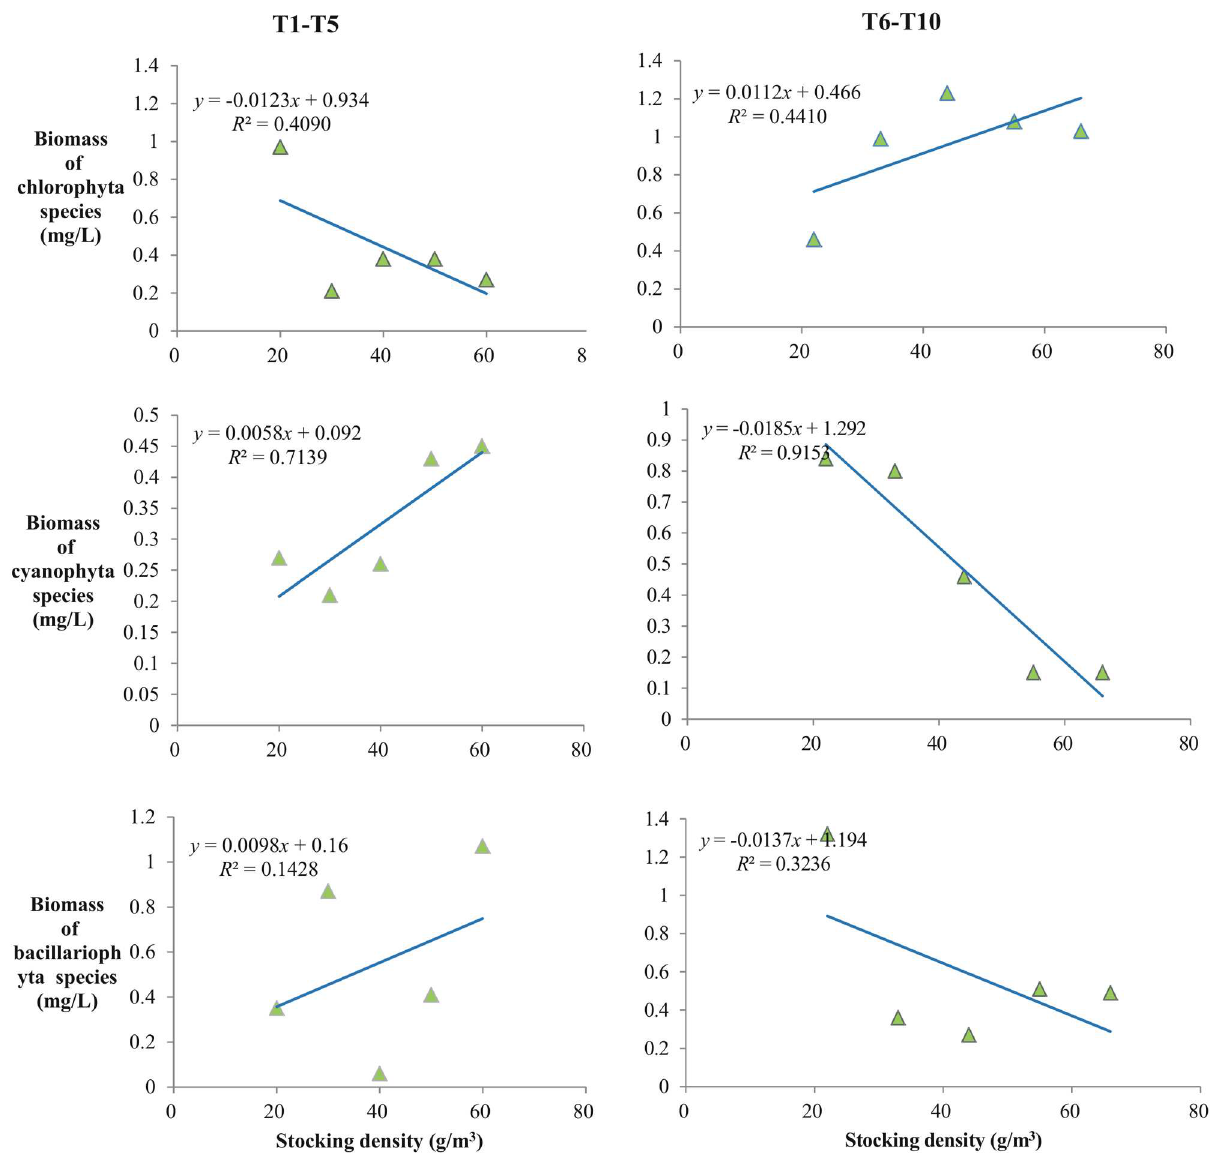
Fig 4. Linear correlation of stocked fish density with biomass of three dominant phyla at day